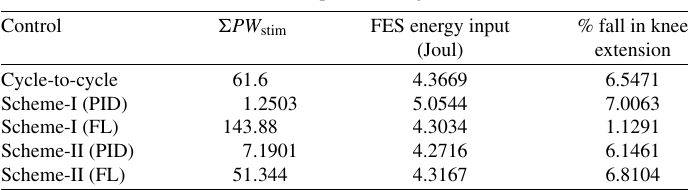
graph of Fig. 21 summarise the results based on these 3 criteria. Especially the bar graph portrays a clear picture of these criteria associated with the control